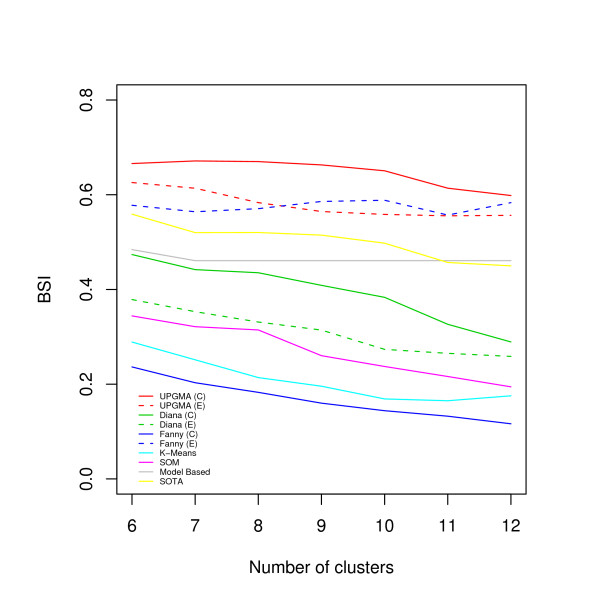
BSI for various clustering algorithms applied to the positively expressed genes in yeast sporulation data with functional classes from FatiGO.